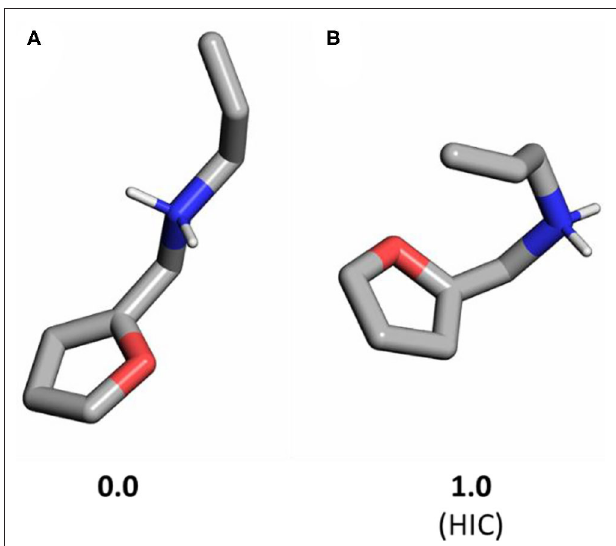
FIGURE 2 | Conformers of substrate 1a without CB[7]: (A) most stable unfolded structure; (B) hair-pin induced (HIC) conformer directly preceding the Diels-Alder transition state (yielded by an IRC calculation). Relative Gibbs free energies are shown in kcal/mol. Non-polar hydrogens are hidden for